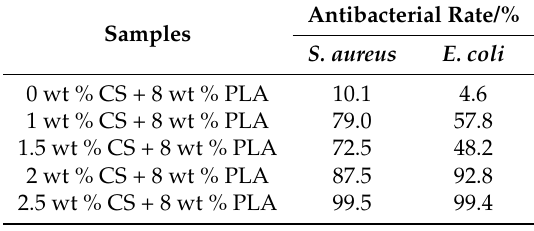
Table 6. Antibacterial performance of fibrous membranes fabricated with different mass ratios.